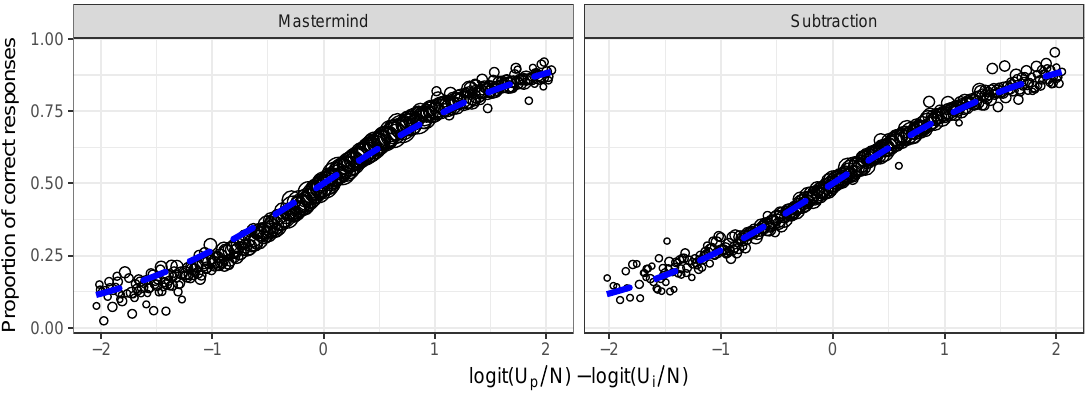
Figure 6. A visualisation of model fit for both analysed games, by comparing observed (black dots) and expected (blue line) probabilities of a correct response for each of the binned differences between the logits of u p / n p and u i / n i